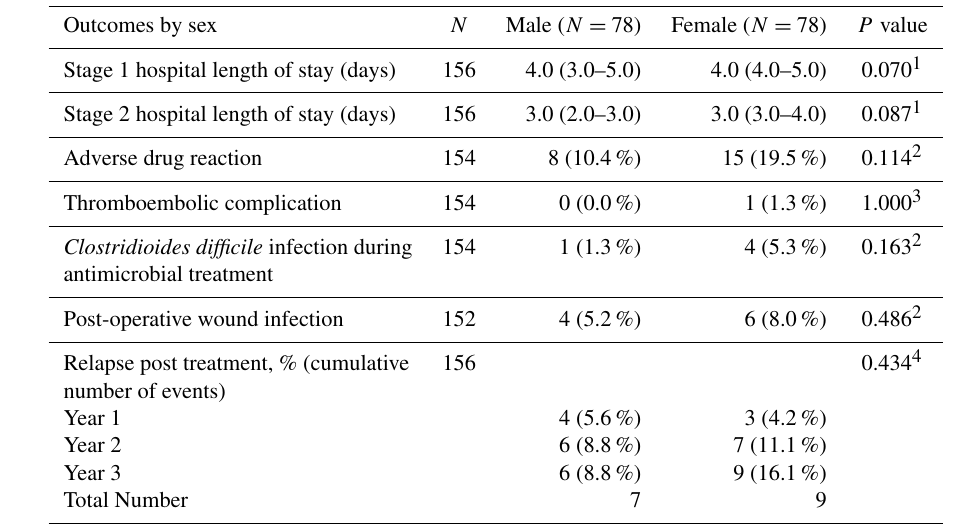
Table 2. Summary of outcome variables in male and female patients.